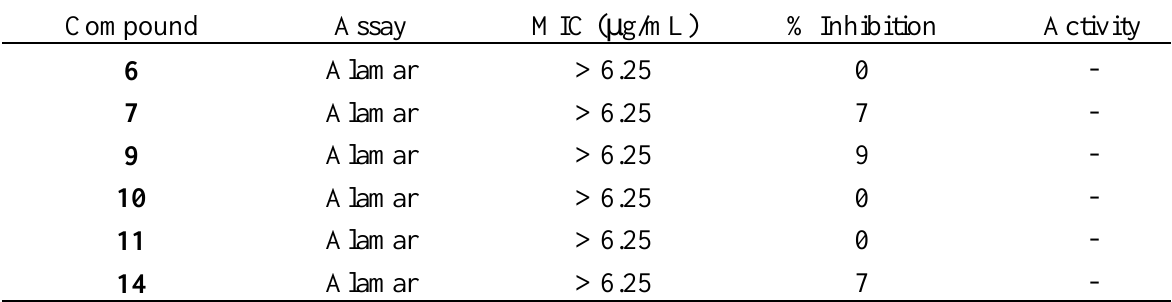
Table 2. Antitubercular activity of quinoxaline compounds 6-7, 9-11 and 14 .